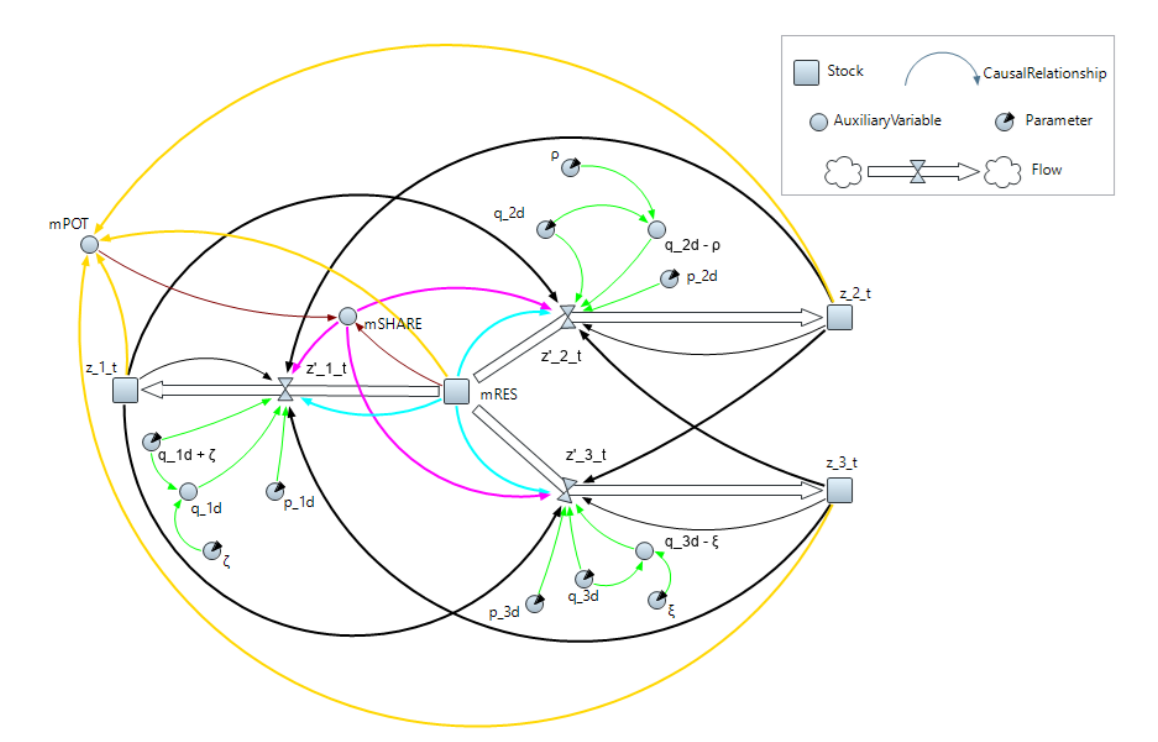
Figure 2. UCTT-SFN model. Cause–effect relationships affecting market potential (yellow), market share (brown), coefficients of the technologies diffusion dynamics (green). Cause–effect relationships determined by market share (purple), residual market (light blue), cumulative consumptions on the same (internal-influence, in grey), as well as on different (cross-influence, in black)